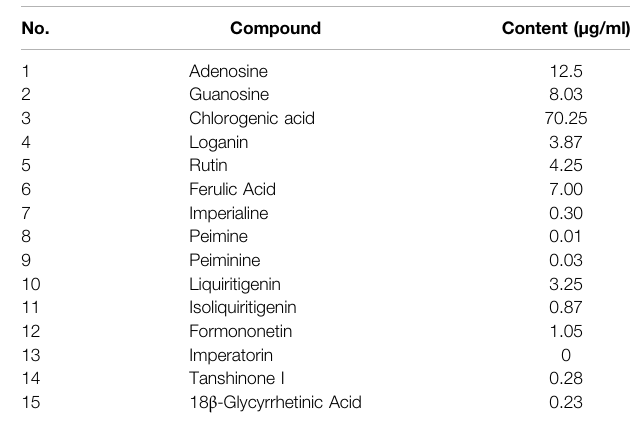
TABLE 1 | Determination of 15 detected compounds in